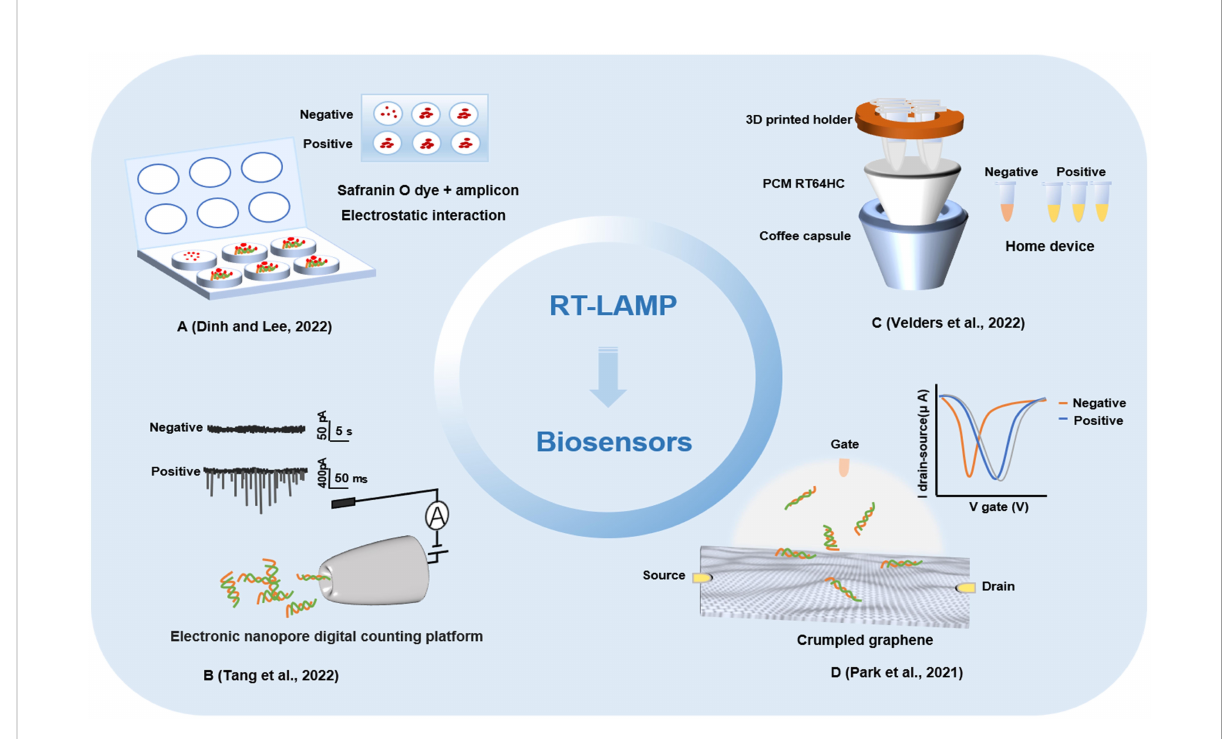
FIGURE 4 Other biosensors detection methods based on loop-mediated isothermal ampli fi cation technology. (A) A fully integrated paper microdevice of using Safranin O dye coupled with loop-mediated isothermal ampli fi cation. (B) Reverse transcription loop-mediated isothermal ampli fi cation coupled glass nanopore digital counting method. (C) T-Cup: A cheap, rapid, and simple home device for isothermal nucleic acid ampli fi cation. (D) A crumpled graphene fi eld-effect transistor